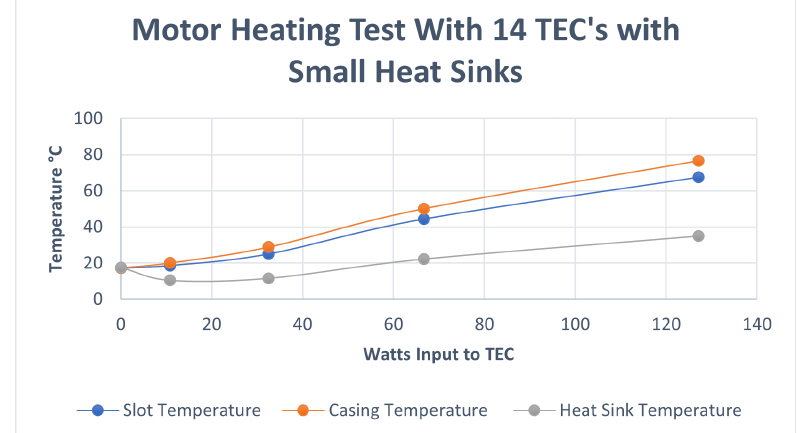
Figure 11. The graphed results of the heating with the TECs and small heat sinks.